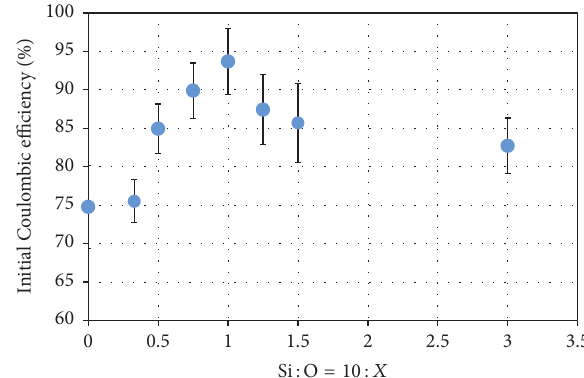
Figure 11: Cycling characteristics of the composite anode (red) and a Si particle reference (blue).